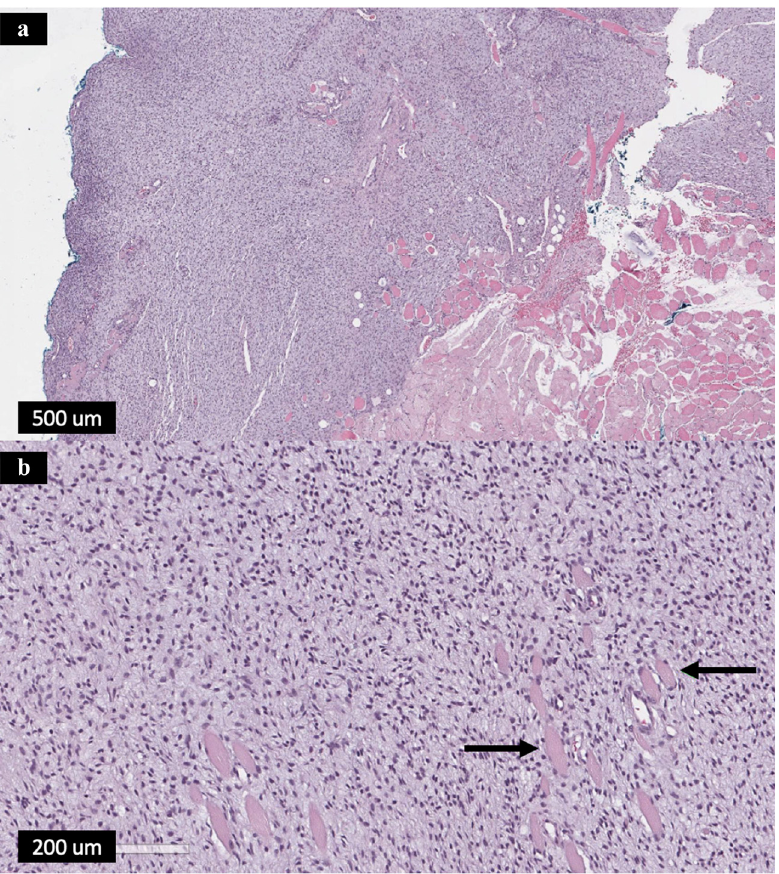
Figure 2: Laryngeal myxosarcoma, dog: ( a ) proliferative spindle to stellate cells form disorganized bundles and arrays within a myxoid matrix. Hematoxylin and eosin. ( b ) Neoplastic spindle to stellate cells in fi ltrate between and separate entrapped myo fi bers ( arrows )